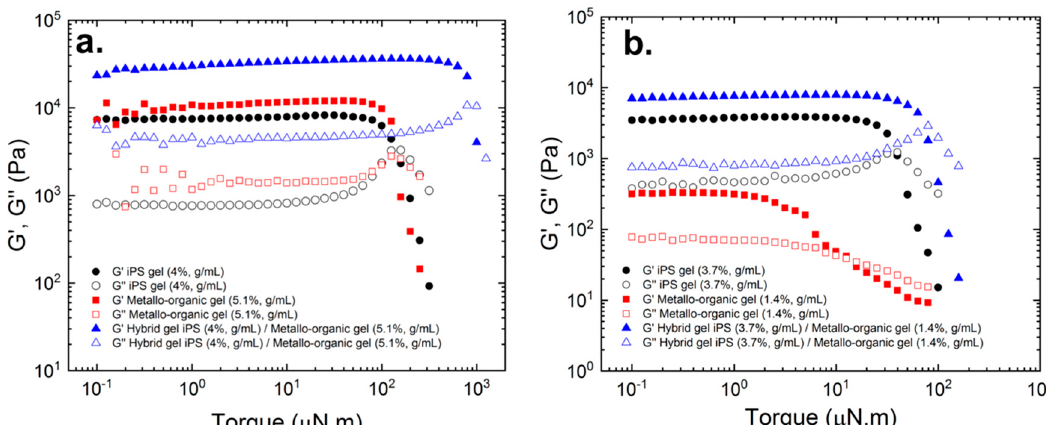
Figure 3. Storage (full symbols) and loss (empty symbols) modulus as a function of oscillation torque, at a constant frequency of 1 Hz and a temperature of − 1 °C for: ( a ) Pure iPS gel, 4%, g/mL (black), pure metallo-organic polymer gel 5.1%, g/mL (red), and representative hybrid gel (blue) with a fixed concentration of iPS (4%, g/mL) and variable concentration of metallo-organic polymer (5.1%, g/mL). ( b ) Pure iPS gel, 3.7% g/mL (black), pure metallo-organic polymer gel, 1.4%, g/mL (red), and representative hybrid gel (blue) with a fixed concentration of metallo-organic polymer (1.4%, g/mL) and variable concentration of iPS (3.7%, g/mL).